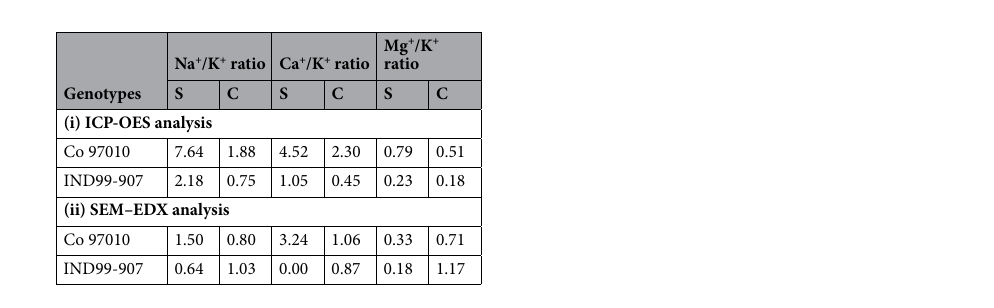
Figure 2. Root anatomical changes in responses of IND99-907 and Co 97010 under salinity stress ( A ) Root anatomical images showing the vacuolization of cortex and thickening of metaxylem vessels in Co 97010 as compared to no significant changes in IND99-907. ( B ) Scanning Electron Micrograph showing thickening of protoxylem with circular xylem vessels in Co 97010 as compared to irregular shaped xylem vessels in IND99- 907 and, EDAX analysis showing elemental composition of roots under salinity stress. ( a ) Root anatomical characterization under controlled and stressed roots of Co 97010 and IND99-907. ( b ) Section Electron micrograph and EDAX under controlled and stressed roots of Co 97010 and IND99-907.